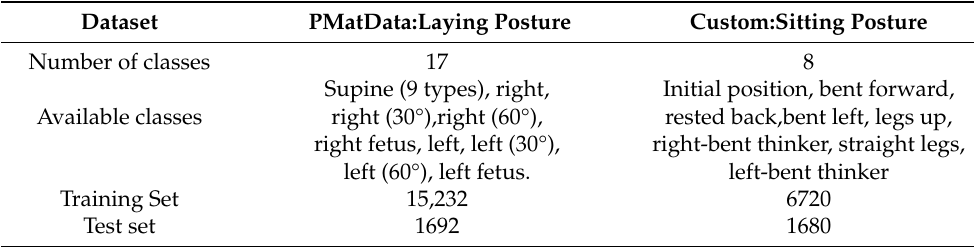
Table 2. Characteristics of the datasets.